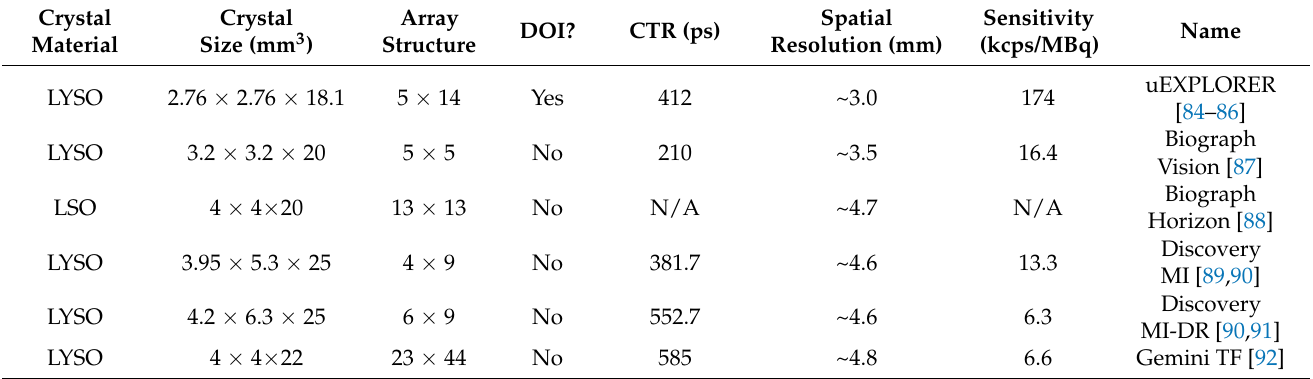
Table 2. Scintillation crystals used in WB-PET and their